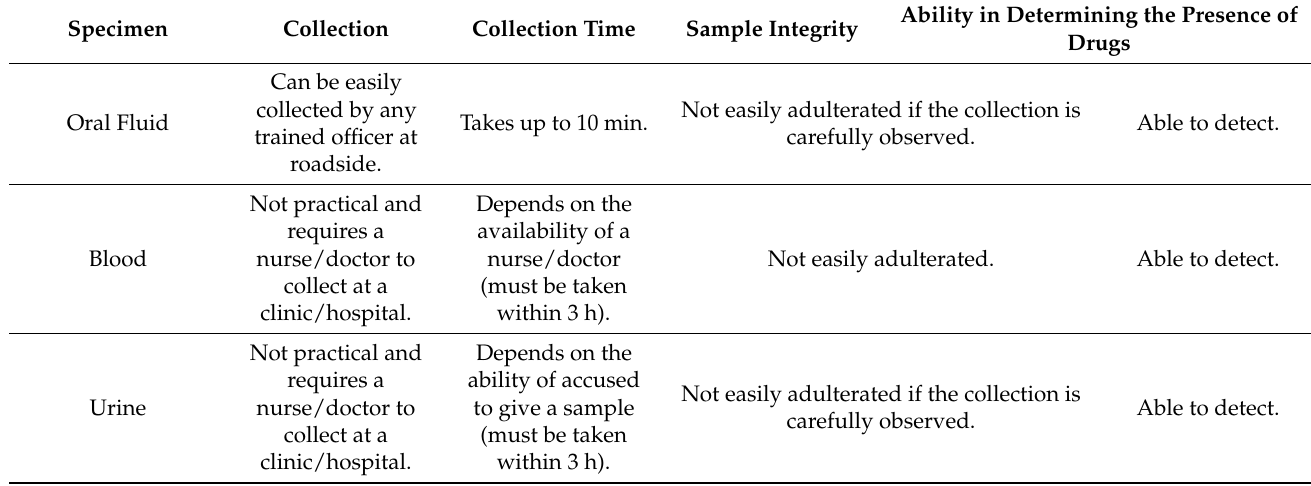
Table 3. Characteristics of oral fluid, blood, and urine relating to roadside drug